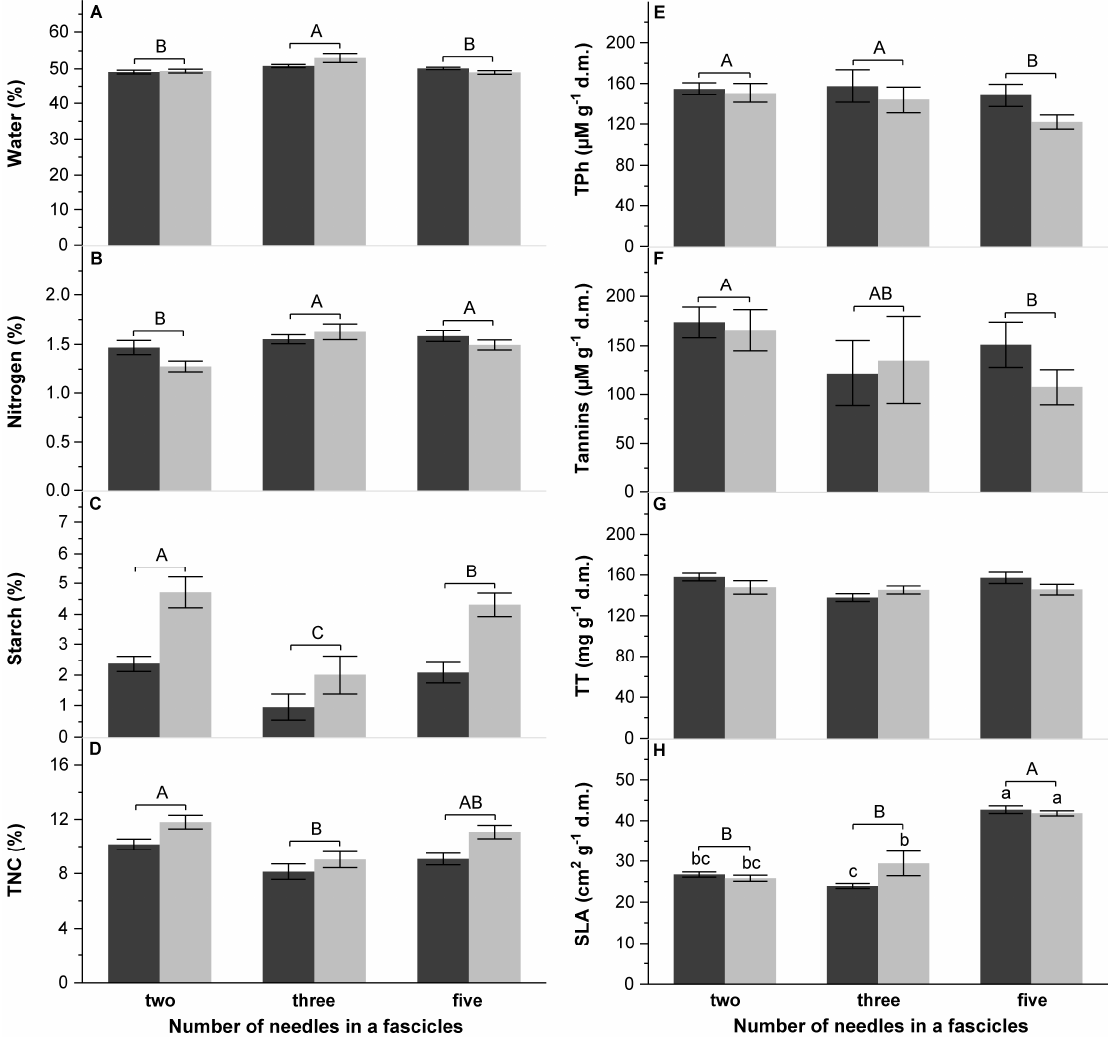
Figure 8. Mean values (±SE) of water ( A ), nitrogen ( B ), starch ( C ), TNC ( D ), TPh ( E ), tannins ( F ), and TT ( G ), as well as SLA ( H ), of needles of pine species with different numbers of needles in fascicles (two, three, and five) achieved over two consecutive months of collection of plant material—April (dark) and May (light). Lowercase letters above the bars indicate result of Tukey’s post hoc test ( α = 0.05) for interaction number of needles × month, and uppercase letters indicate result for number of needles treatment (see also Table 3). Levels not connected by same letter are significantly different.